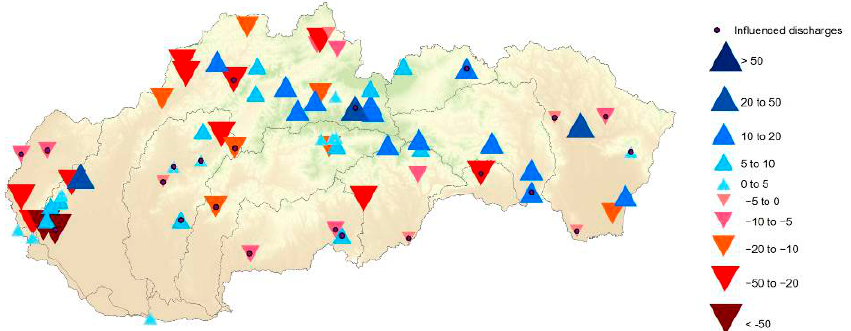
Figure 6. Changes in values of Q 364d,rr from 2001–2015 vs. 1961–2000 (% of increase/decrease).